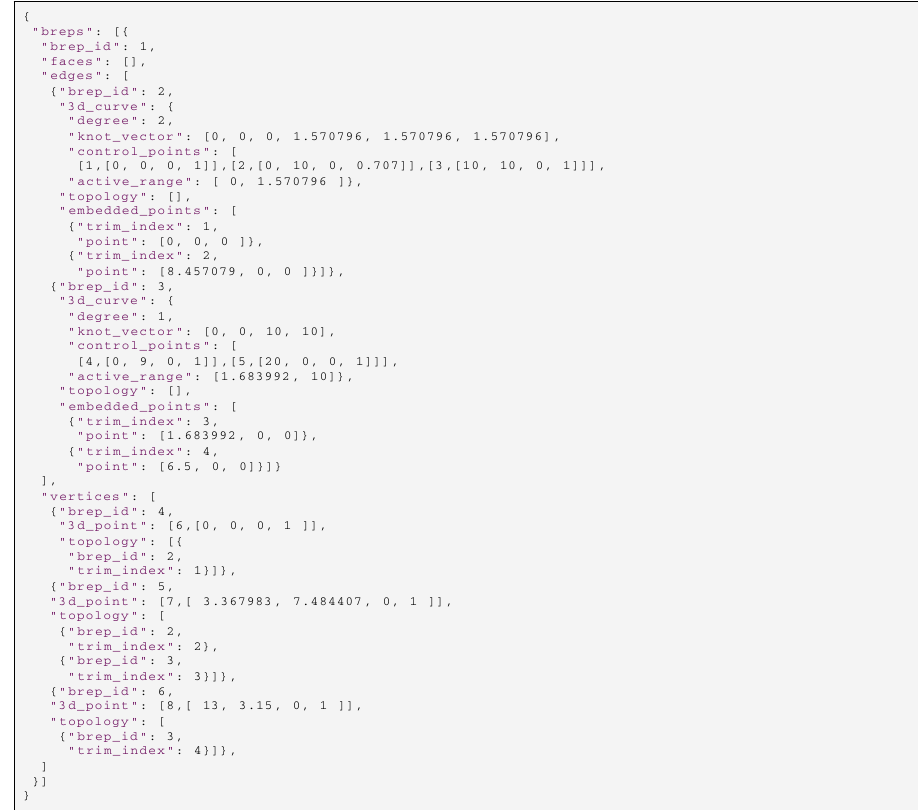
Listing 8 Example curve element with embedding: the IBRA exchange format provides the data for the geometry in Fig. 19